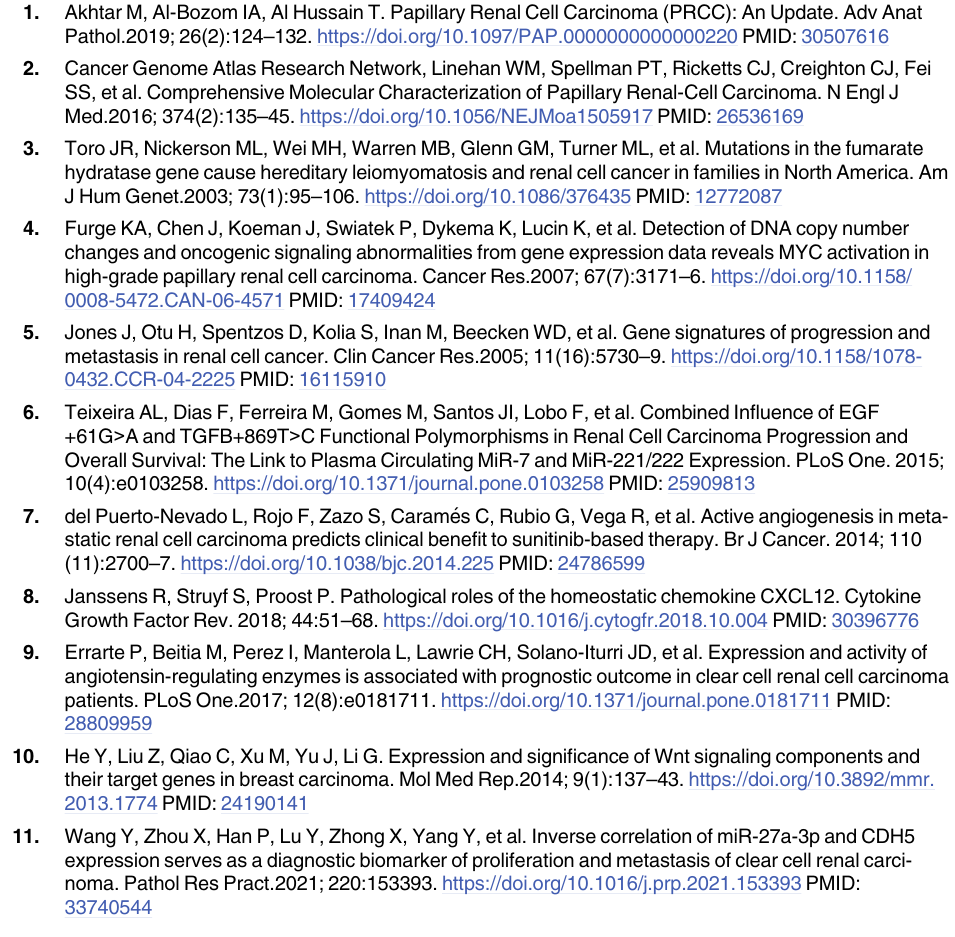
S1 Fig. Volcano plot of DEGs in three datasets. Red represents upregulation, green repre- sents downregulation, and grey represents no significant difference. A |log | > 1 and adjusted P value < 0.05 were considered to indicate statistically significant differential